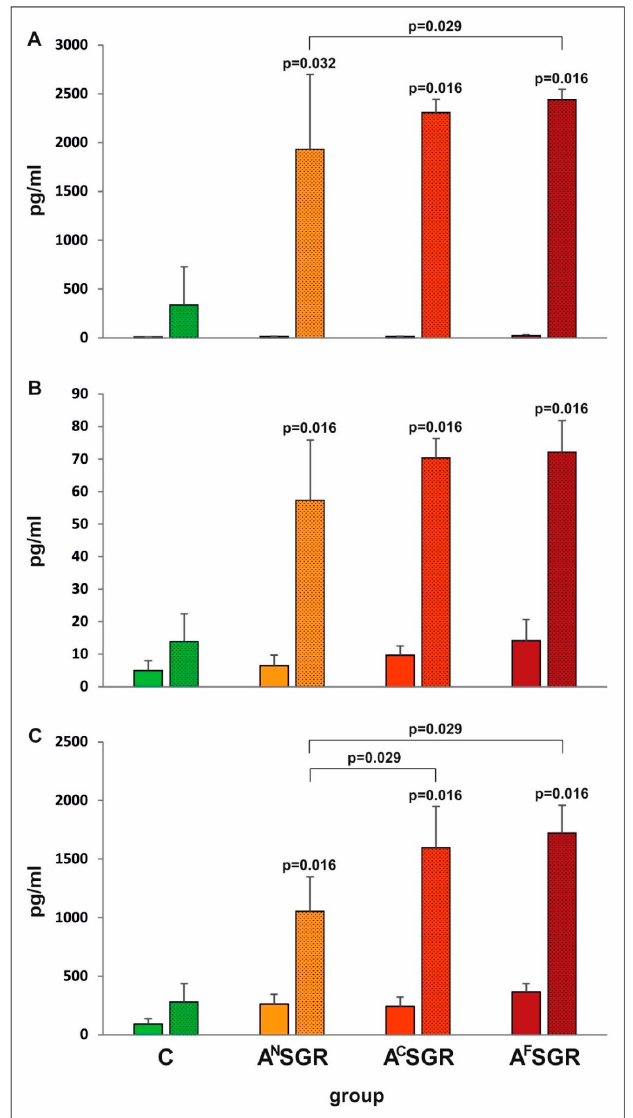
Figure 3. In vitro IFN- γ ( A ), IL − 2 ( B ) and IL − 10 ( C ) cytokine release by splenocytes from immunized and control mice in unstimulated (plain bars) or TLA-stimulated (dotted bars) cultures. p values are provided above the bars to indicate significant differences in cytokine synthesis between TLA- stimulated splenocytes from immunized and control nonimmunized mice (C); statistically significant differences between the TLA-stimulated cultures of immunized groups are marked with brackets.